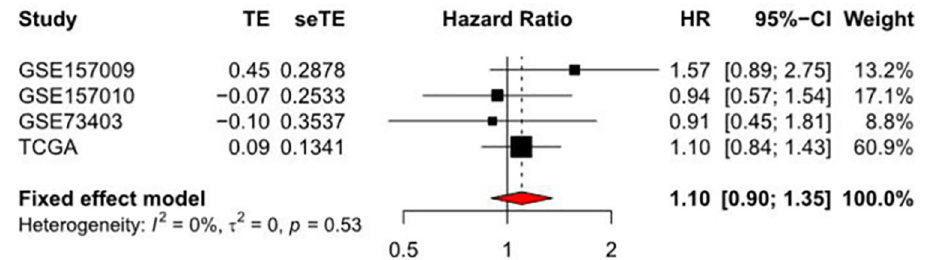
Fig 12. Forest plot of the hazard ratio by COX analysis related to RIOX2 gene in squamous cell lung cancer. The abscissa represents the hazard ratio and the ordinate represents the sample